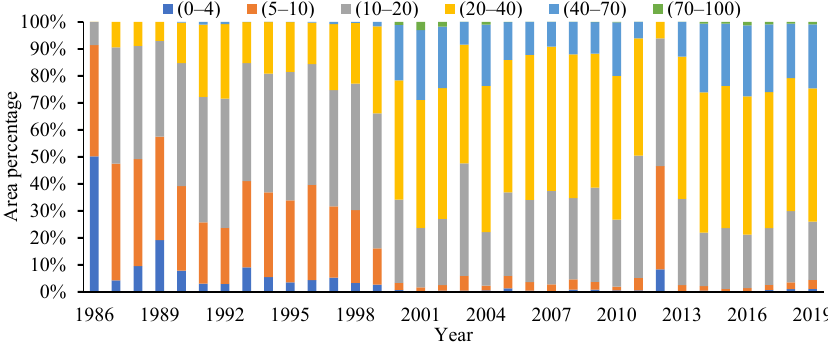
Figure 2. Spatial distribution of the frequency of clear Landsat observations in the YRB from 1986 to 2019.